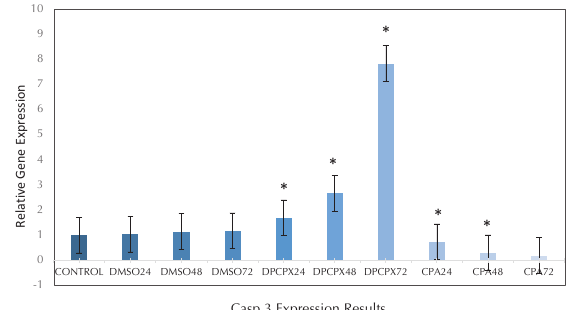
-1012345678910 Figure 4. Effects of Adenosine A1 Receptor on the Levels of Casp3 Expression in T47D Cells in 24, 48, and 72 hours After Treatment. Note . Casp3 gene expression up-regulated with DPCPX treatment and down-regulated with CPA treatment especially at 72 hours after treatment ( P > 0.05).